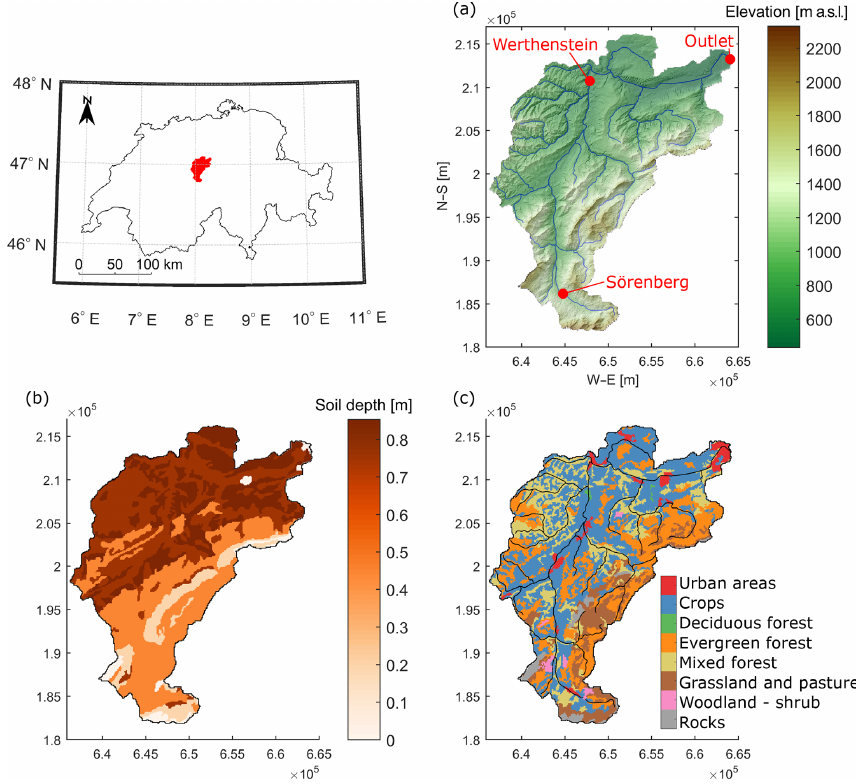
Figure 1. (a) Digital elevation model (DEM) of the Kleine Emme basin and location of discharge gauges (source SwissAlti3D, 2017), (b) soil depth, derived from the Swiss soil map (Bodeneignungskarte, 2012), and (c) land cover derived from Corine Land Cover map (CLC, 2014). The coordinate system is CH1903. Table 1. Hydrological performance for the simulation period 2004–2016 at the three flow monitoring stations in terms of correlation coeffi- cient ( r ), Nash–Sutcliffe efficiency (NSE), and root mean square error (RMSE) for data simulated at the hourly resolution and aggregated to daily, monthly, and annual